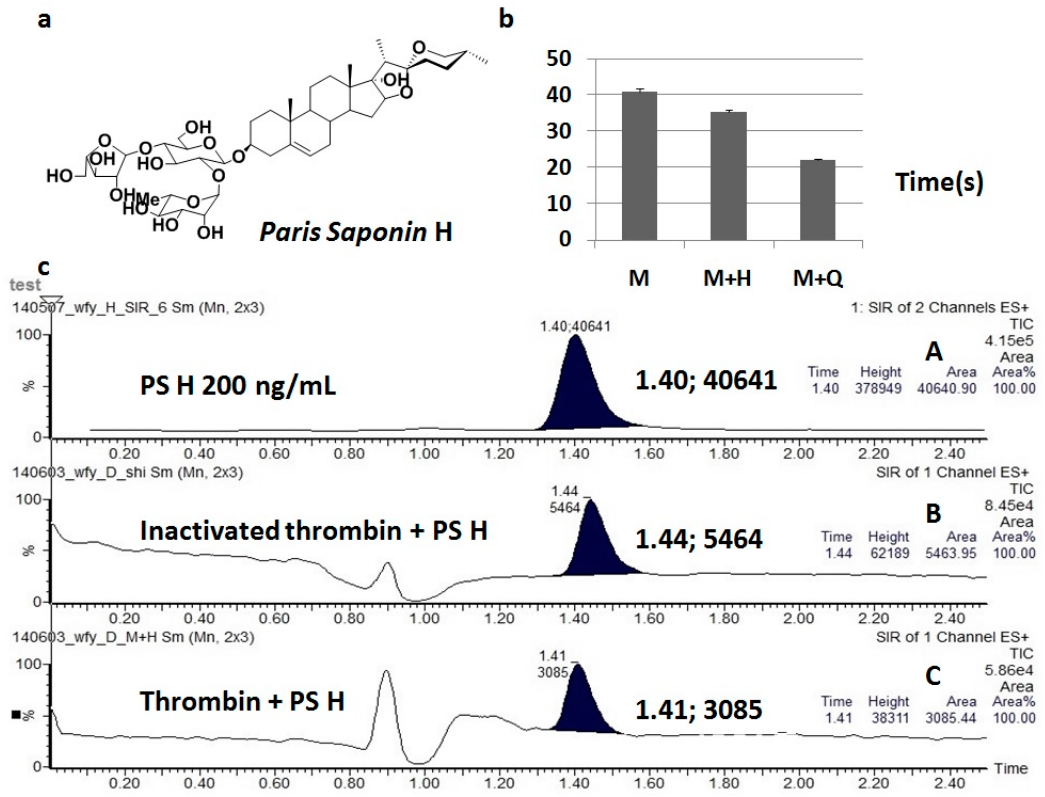
Figure 1. Effect of Paris saponin H (PS H) and Paris fargesii var. brevipetala (PF) saponin extract on thrombin; ( a ) structural formula of PS H; ( b ) coagulation time in vitro ( n = 5); M: Thrombin + ultrapure water; M+H: Thrombin + PS H; M+Q: Thrombin + PF saponin extract; coagulation did not occur in the inactivated thrombin + PS H group; ( c ) UPLC-MS assay results of the substrate from